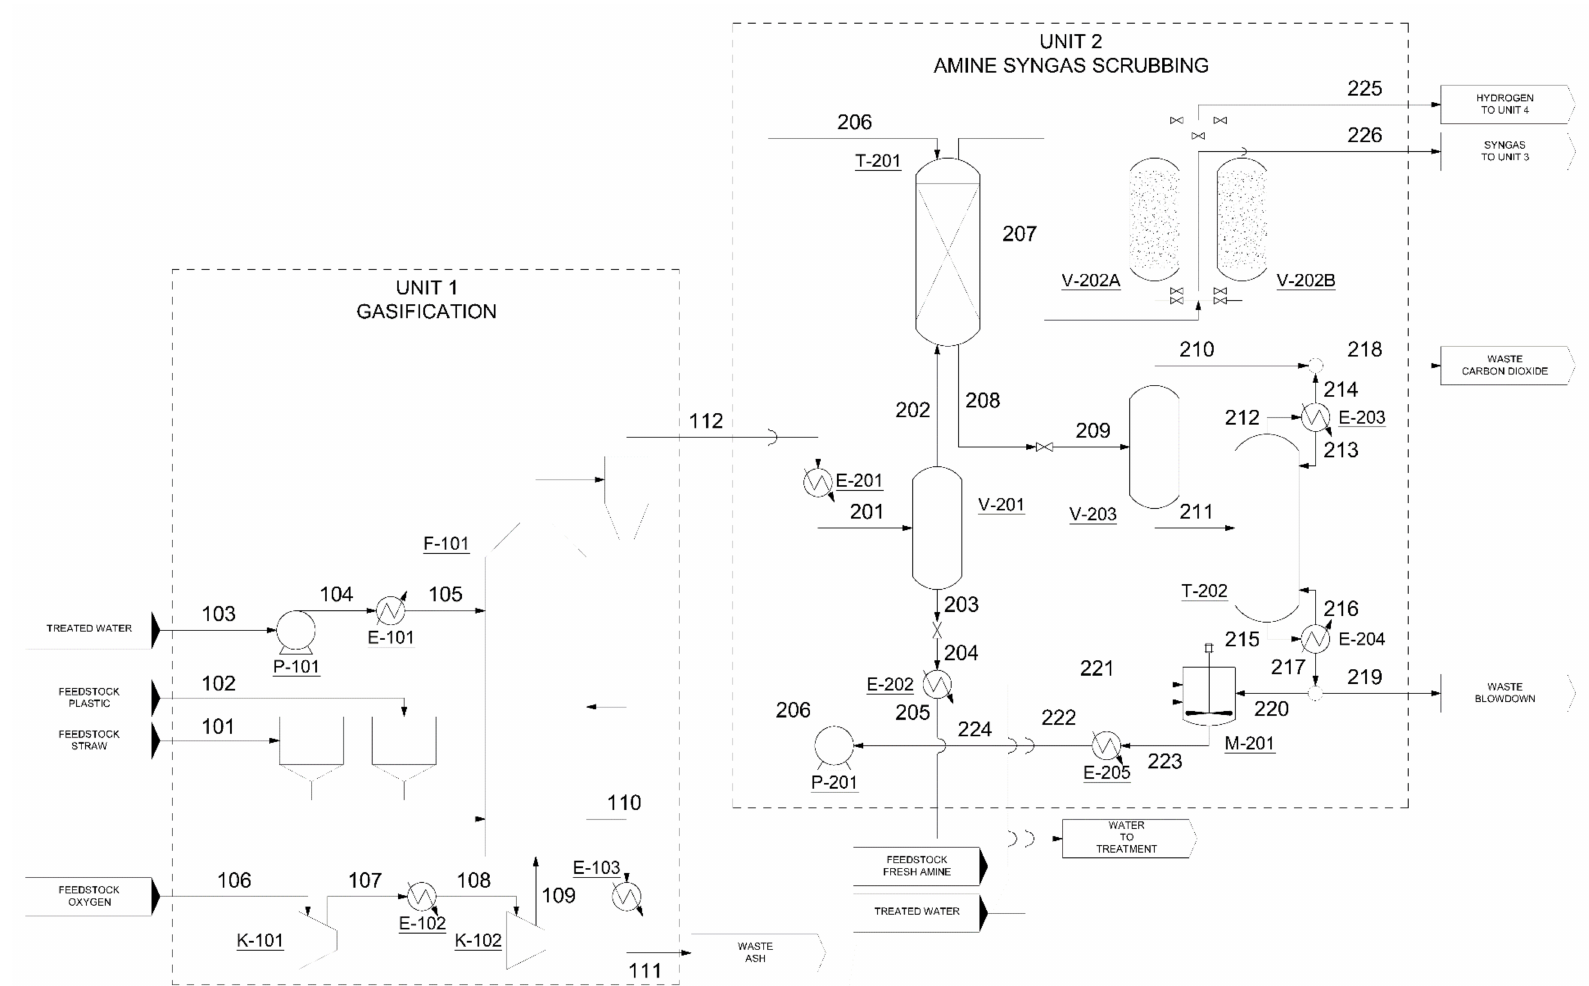
Figure 1. Gasification and amine syngas scrubbing (units 1 and